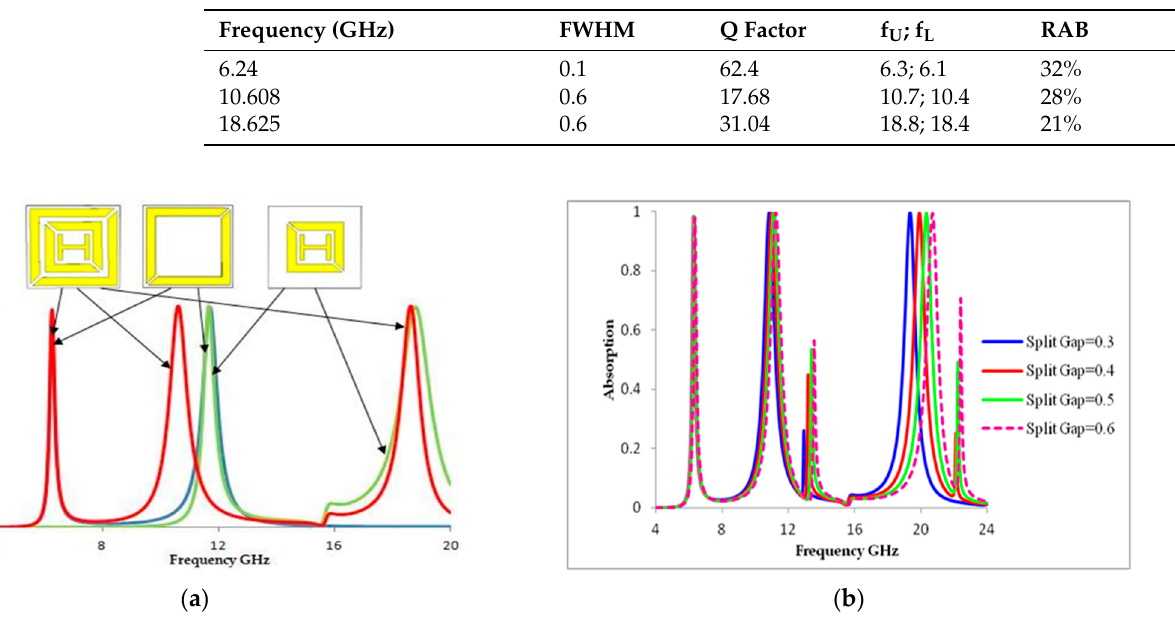
Table 2. The quality factor (Q), FWHM, and RAB results for TM mode.